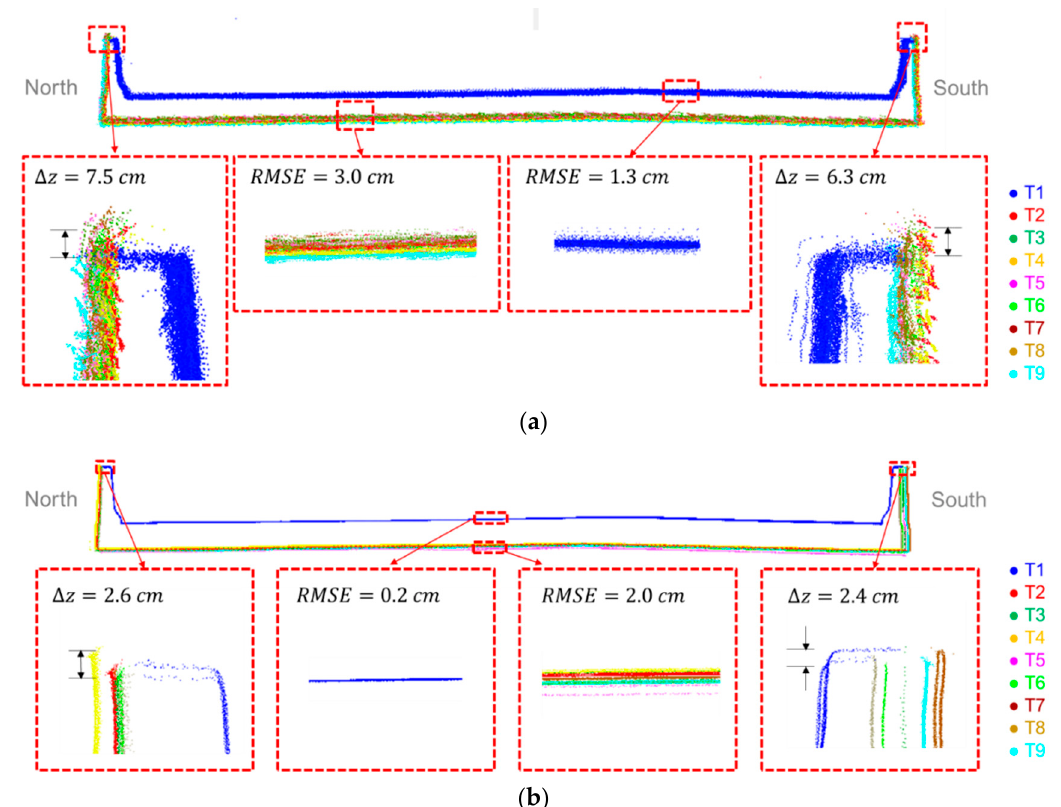
Figure 13. Sample cross-sectional profile of the bridge deck showing the point cloud alignment before registration for the ( a ) PWMMS-HA and ( b ) PWMMS-UHA datasets. Both datasets have nine tracks (T1 is above the bridge and T2–T9 are below the bridge).